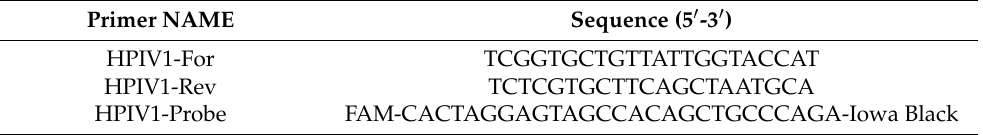
Table 2. Table of Human parainfluenza virus 1 RT-qPCR primers and